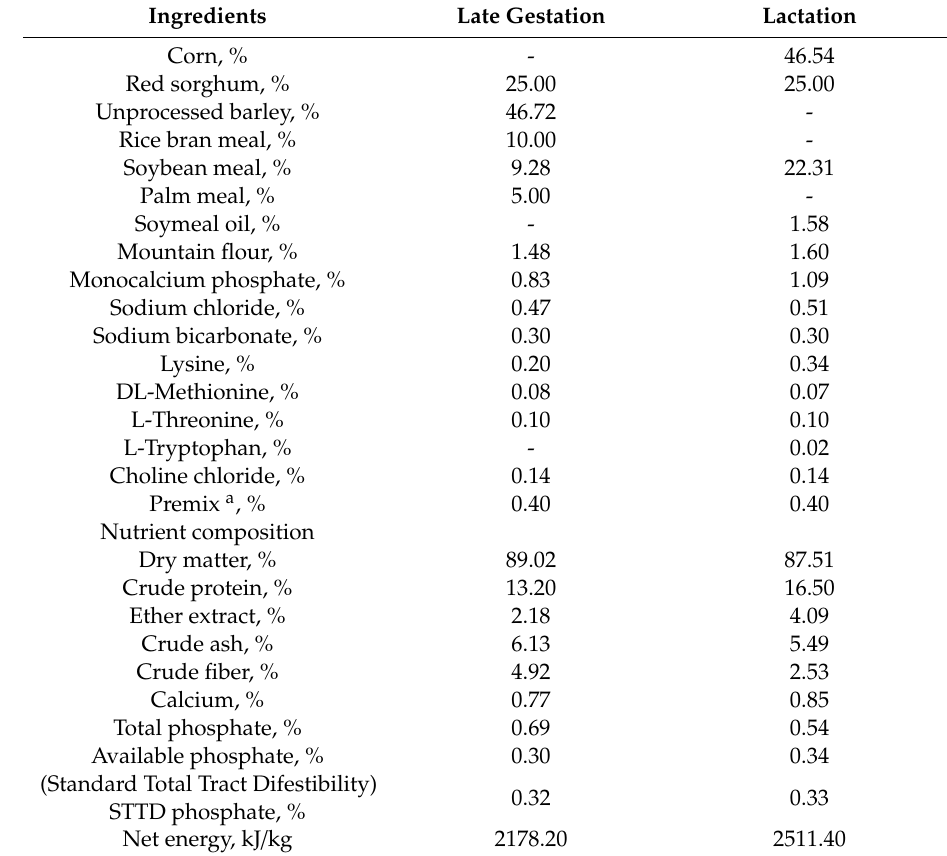
Table 1. Composition of diet for sows during the late gestation and